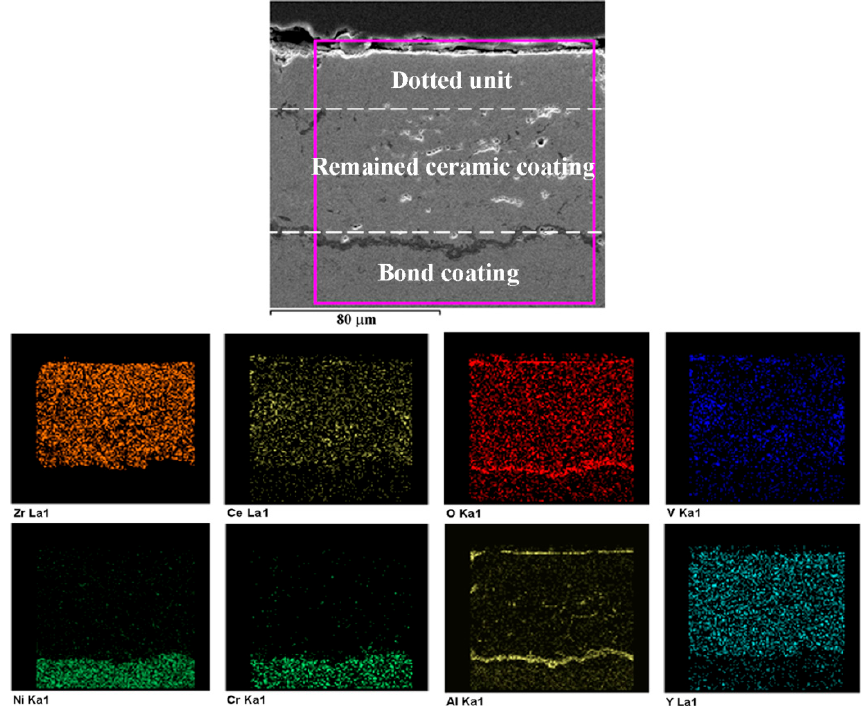
Figure 14. EDS elemental mapping of the cross section of the dotted unit in the dotted specimen after the hot corrosion test.